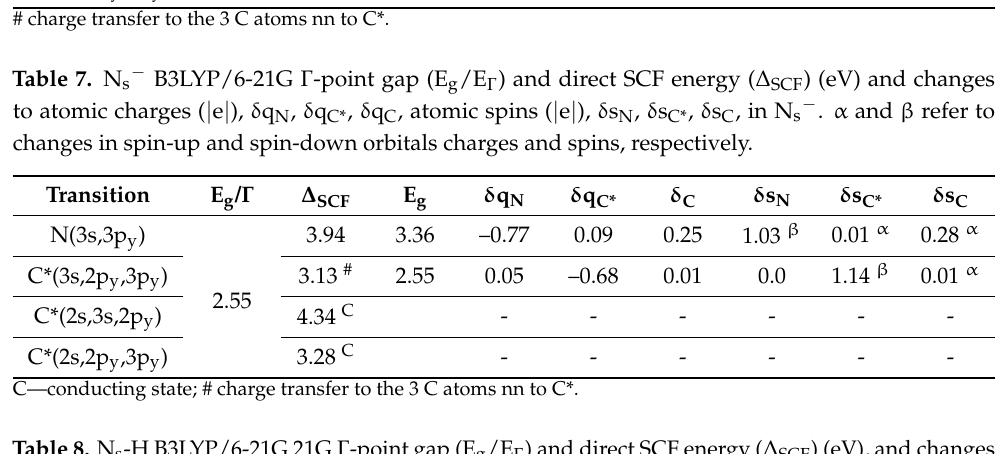
Table 8. N s -H B3LYP/6-21G 21G Γ -point gap (E g /E Γ ) and direct SCF energy ( ∆ SCF ) (eV), and